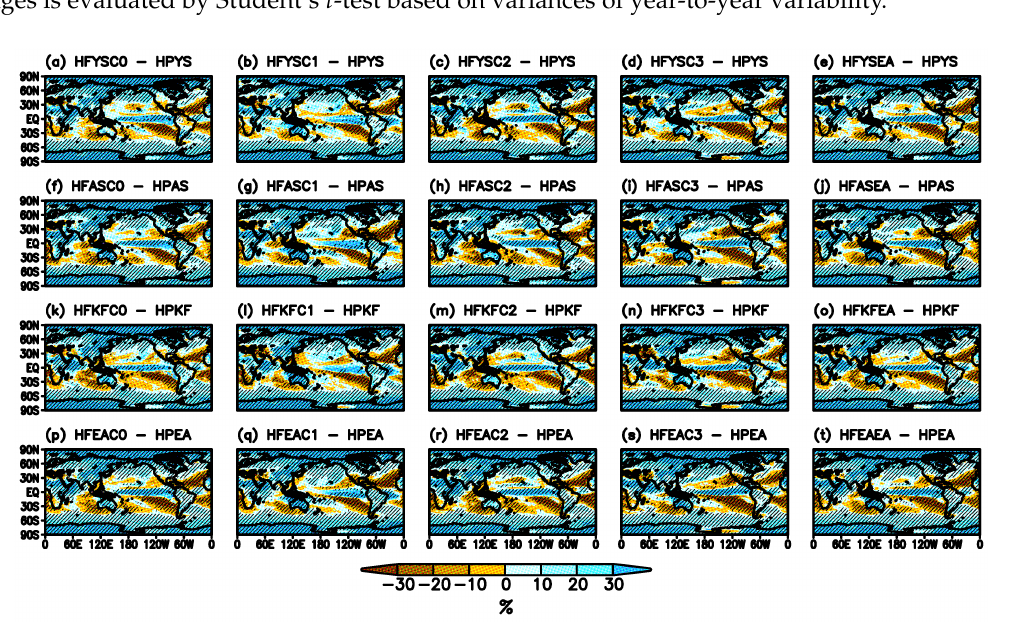
Figure 5. Future changes (2079–2099) in annual average precipitation (%) from the present-day climatology (1983–2003). Change is normalized by the present-day climatology. Hatched regions show changes above the 95% significance level based on Student’s t -test. (First row; ( a – e )) The 60-km model with YS. Changes are calculated from the present-day climate simulations with YS. (Second row; ( f – i )) The 60-km model with the AS scheme. Changes are calculated from the present-day climate simulations with the AS scheme. (Third row; ( k – o )) The 60-km model with the KF scheme. Changes are calculated from the present-day climate simulations with the KF scheme. (Fourth row; ( p – t )) The ensemble average of 60-km model with the three convection schemes (first–third row). (First column; ( a , f , k , p )) Simulations with the SST cluster C0. (Second column) Simulations with C1. (Third column) Simulations with C2. (Fourth column) Simulations with C3. (Fifth column) The ensemble average of simulations with the four SSTs (first–fourth column).